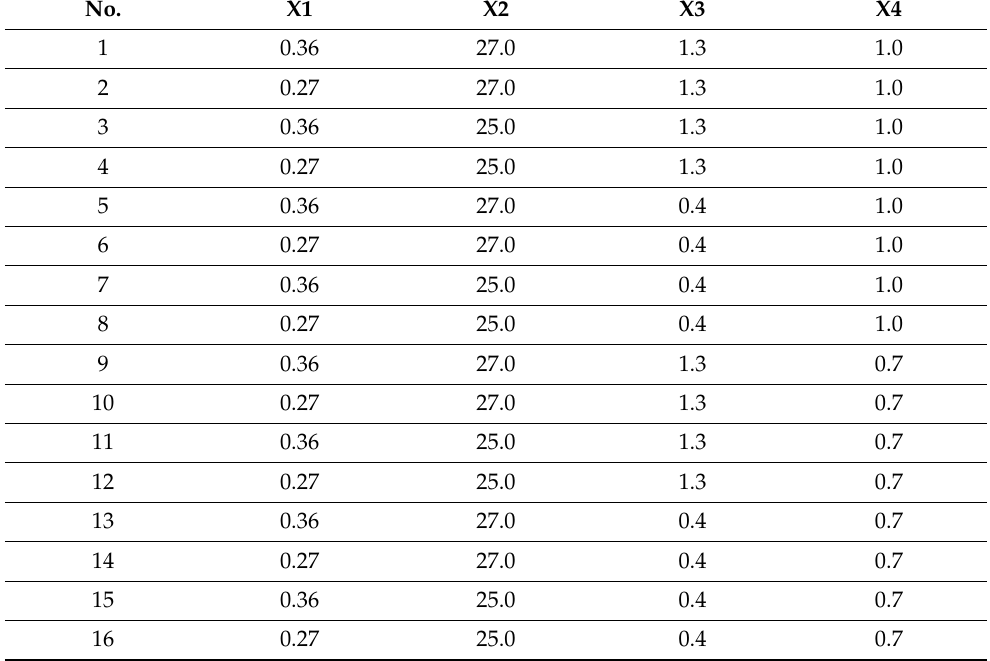
Table 3. A plan of the 2 4 full factorial